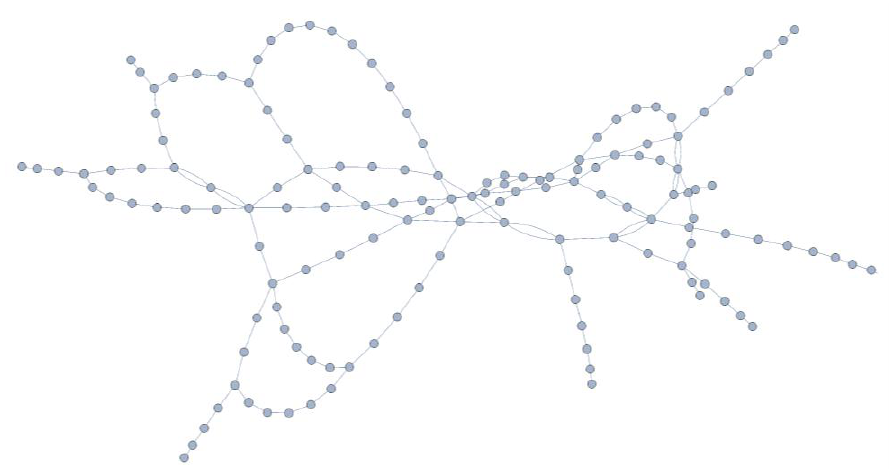
Figure 6. The graph representing the Barcelona subway network using